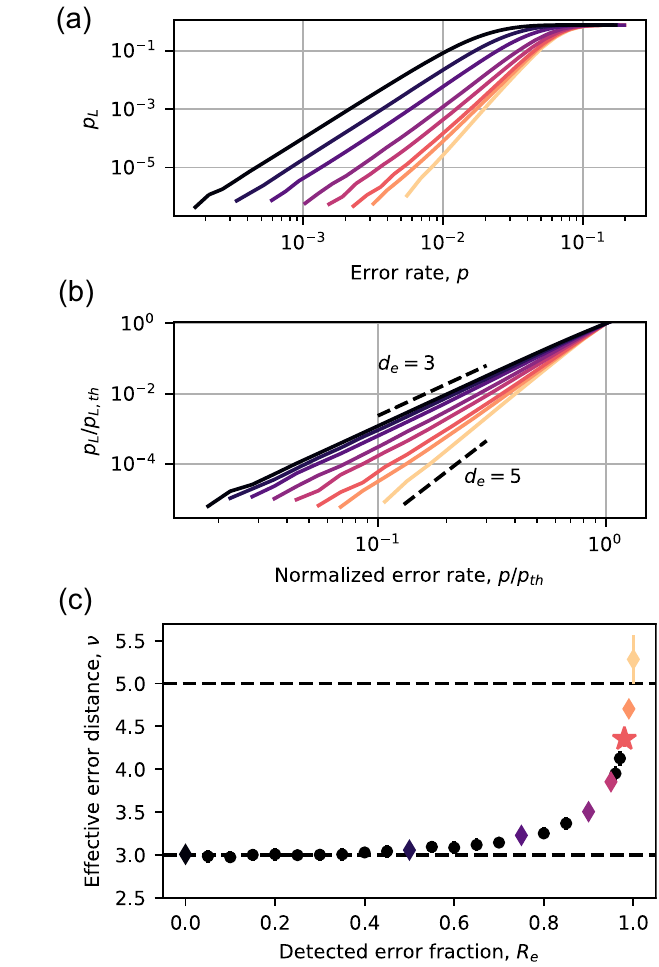
Fig. 4 | Logical error scaling below threshold. a p L vs p at a fi xed code distance d =5forvariousvaluesof R e [colorscorrespondtothediamondpointsinpanel( c )]. In panel ( b ), the physical and logical error rates are rescaled by their values at the threshold. c Logicalerrorexponent ν ,extractedfromtheslopeofthecurvesin( b ). Thedashedlinesshowtheexpectedasymptoticexponentsforpurecomputational errors ( ν p =3) and pure erasure errors ( ν e =5). The error bars indicate the 95% con fi dence interval in the exponent ν , estimated from a chi-squared analysis of the fi